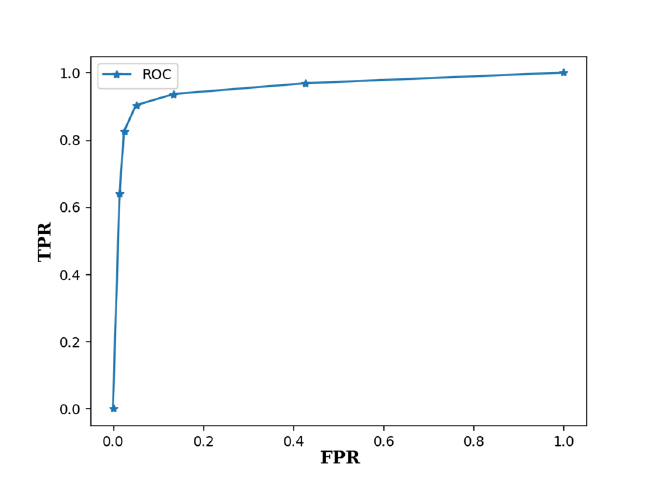
Figure 8. The ROC curve of the proposed algorithm for the testing set. The neural network was = 750 and ITR ratio r = 0.3. The corresponding AUROC is 0.954. trained by a set with size M TR